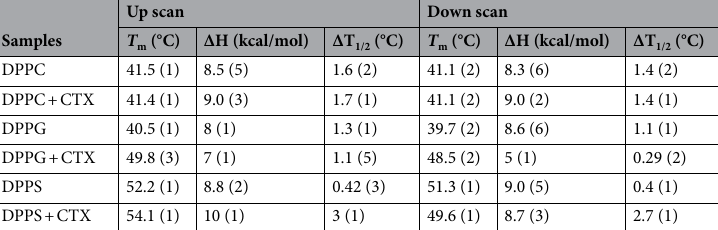
Table 2. Thermal parameters calculated form the calorimetric data in Fig. 4. Mail transition temperature (Tm). Enthalpy variation (H), and main transition width at half maximum (T1/2). For the endothermic (up scan) and exothermic (down scan) cycles. The estimated standard deviations refer to the analysis of two different samples of the same system.